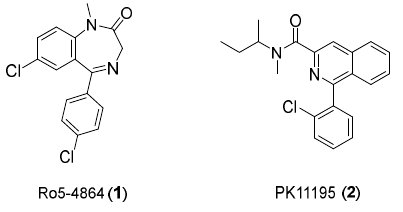
Figure 1. Structures of Ro5-4864 and PK11195. Table 1. Summary of 18 F-radiolabeled TSPO ligands.